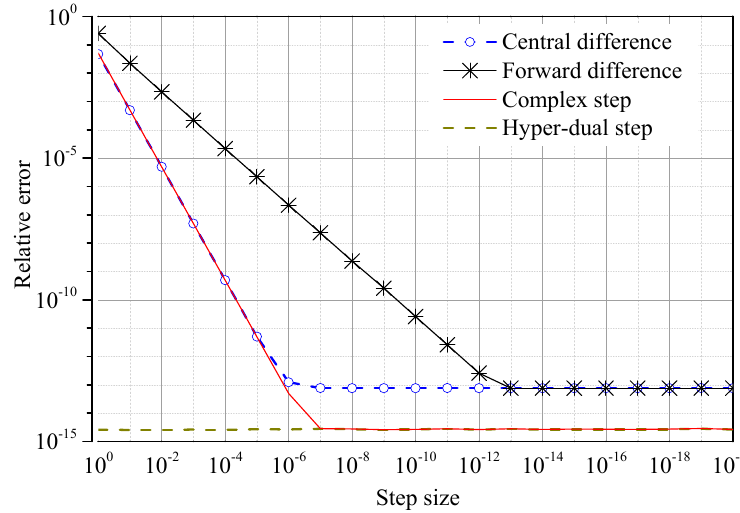
∂∂ K —errors of numerical meth-